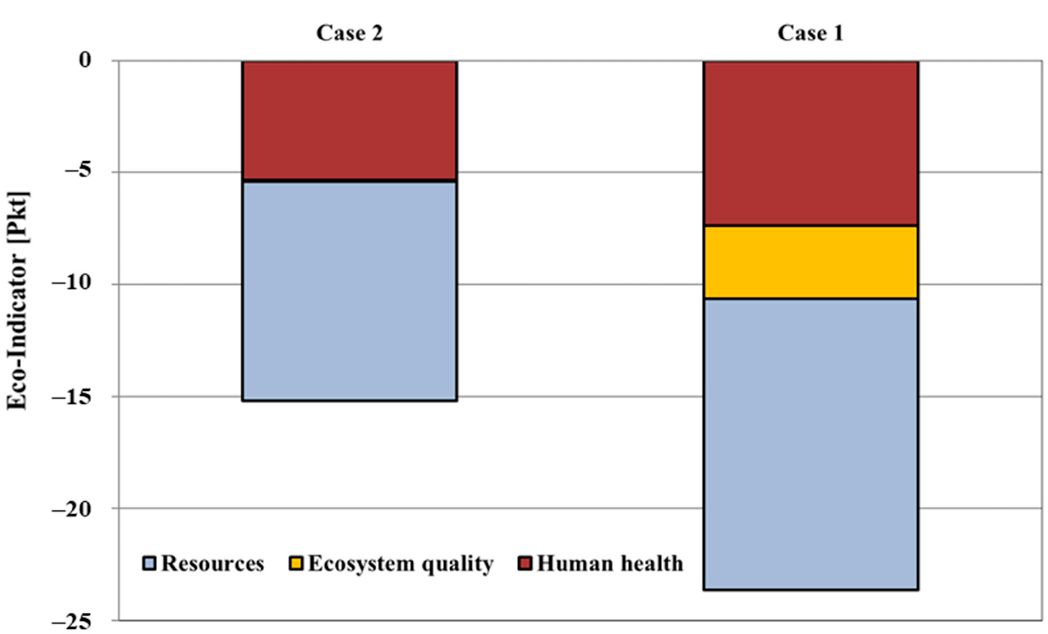
Figure 6. The results of comparative life cycle analysis for production of 1 MWh of electricity from biogas process in Case 1 and Case 2 for different impact categories according to Eco-Indicator 99 method (normalization).